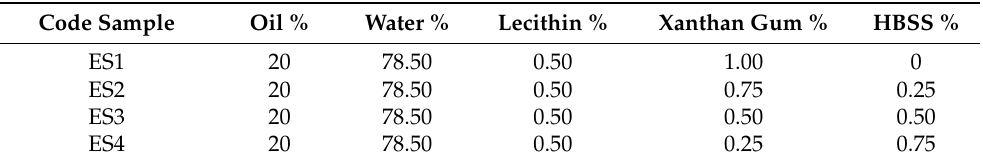
Table 2. Formulation and physicochemical properties of the dressing emulsion stabilized with hy- drocolloids from butternut squash seeds (HBSSs) at pH 10.